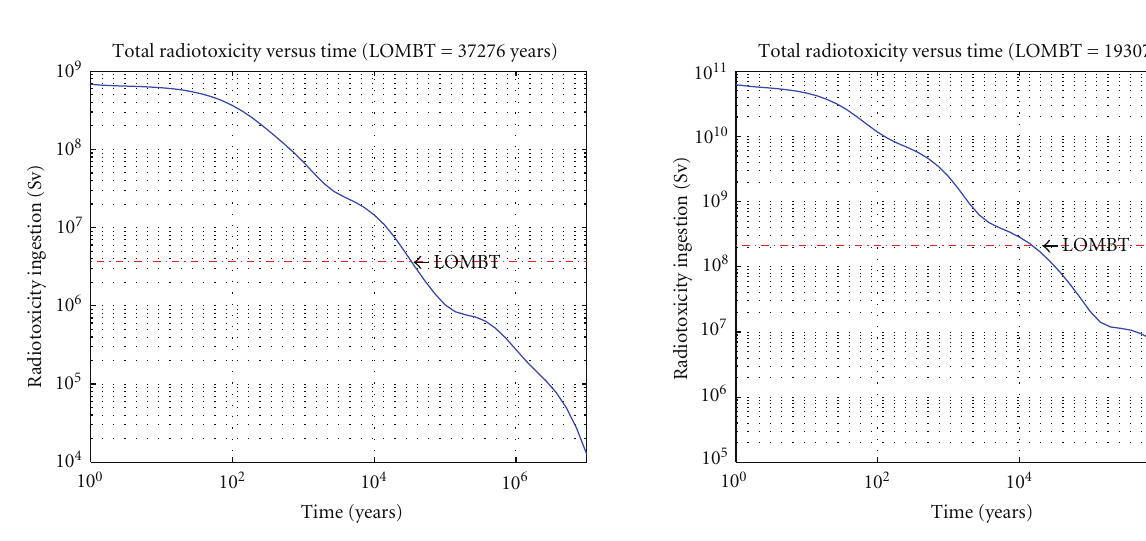
Figure 11: LOMBT of PBMR SNF (FPs, Pu, Am, and Cm). Figure 12: LOMBT of GCFR SNF end first cycle (FPs, Am, and